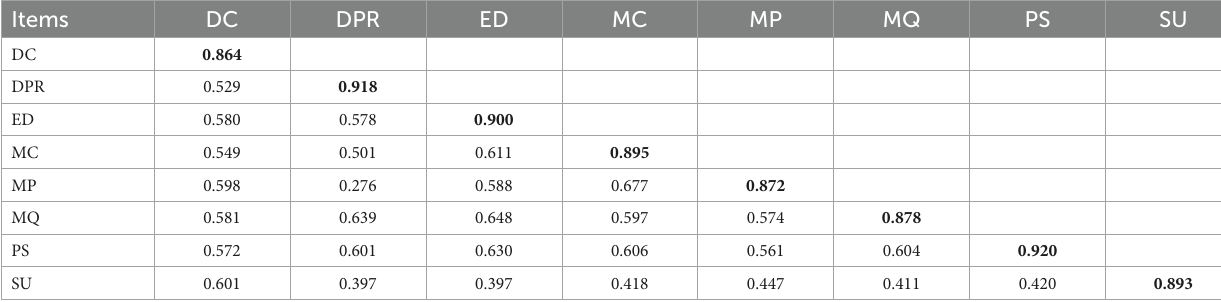
TABLE 5 Discriminative validity. Items